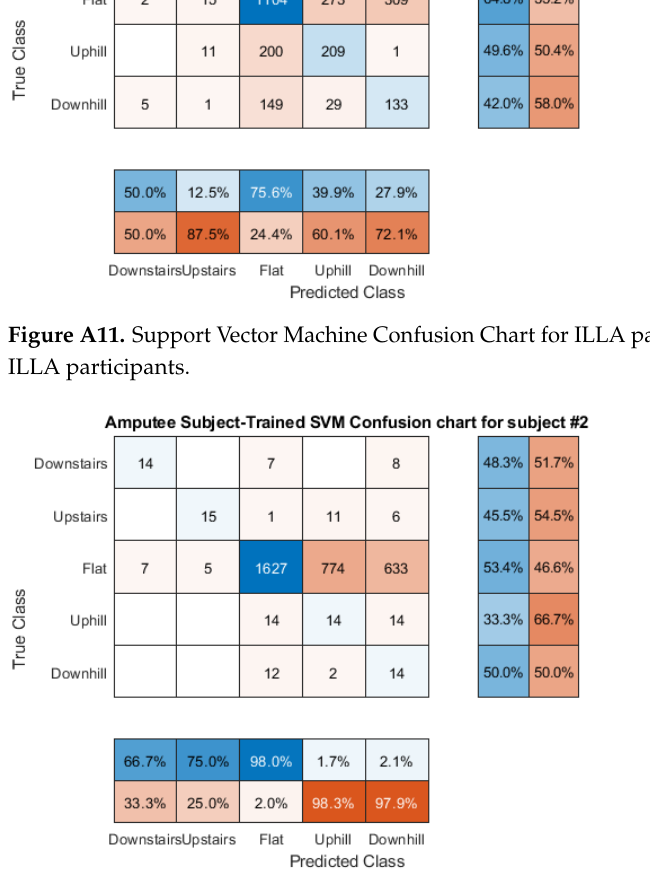
Figure A12. Support Vector Machine Confusion Chart for ILLA participant A2 as trained by all other ILLA